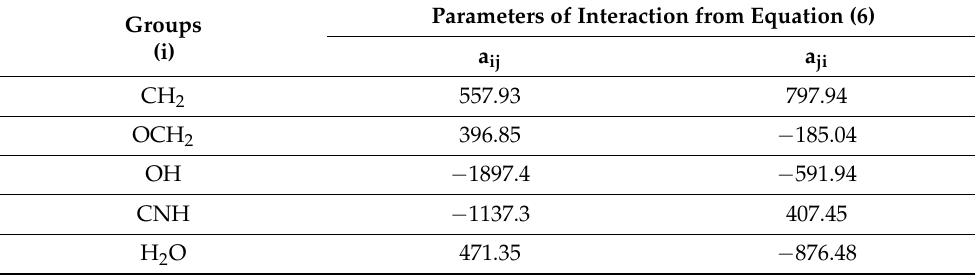
Table 2. Parameters of interaction for model UNIFAC of the PO group (j).